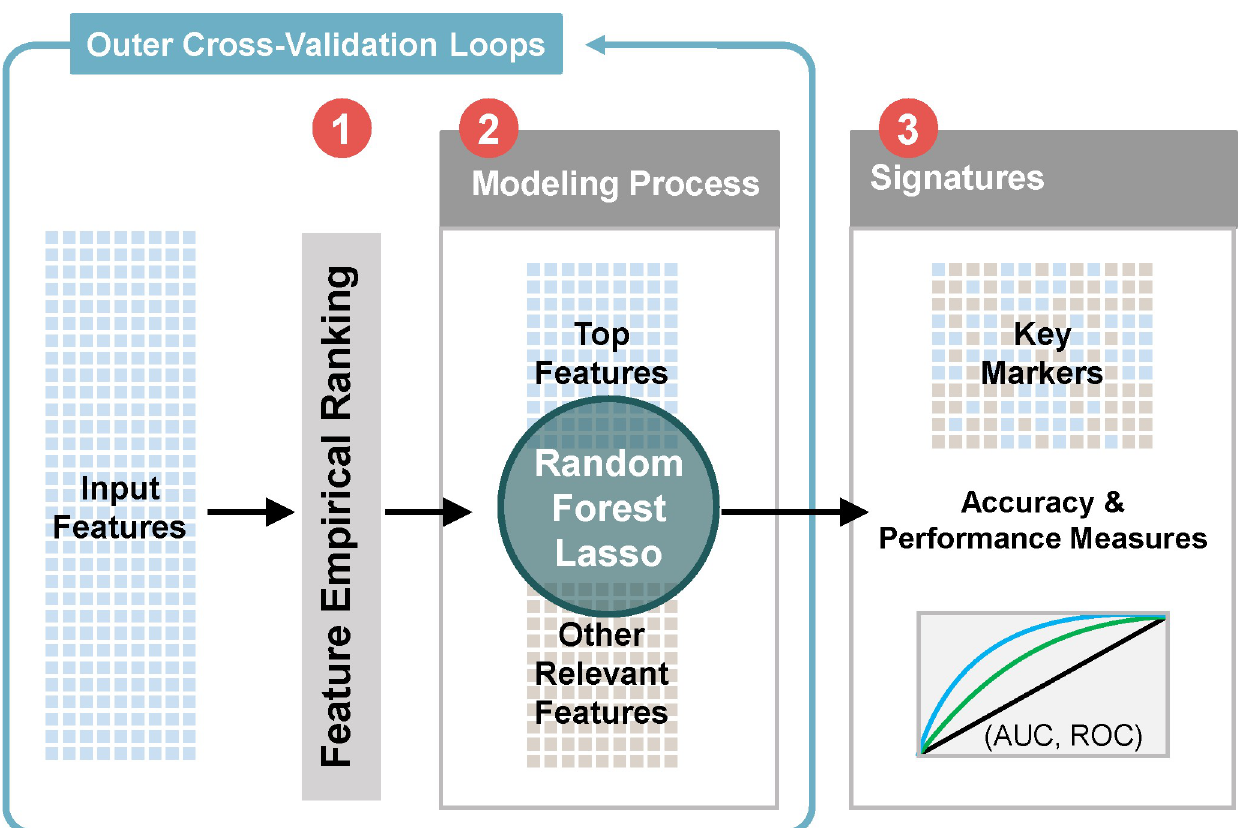
Fig 2. Feature selection and predictive modeling. The flow chart summarizes our analytical processes of data analysis. Feature empirical ranking was utilized to select subsets of top and relevant features which are then utilized in the outer cross-validation loop of the Integrative Modeling Process. Ultimately, signature profiles were identified and predictive accuracy and performance of the models were